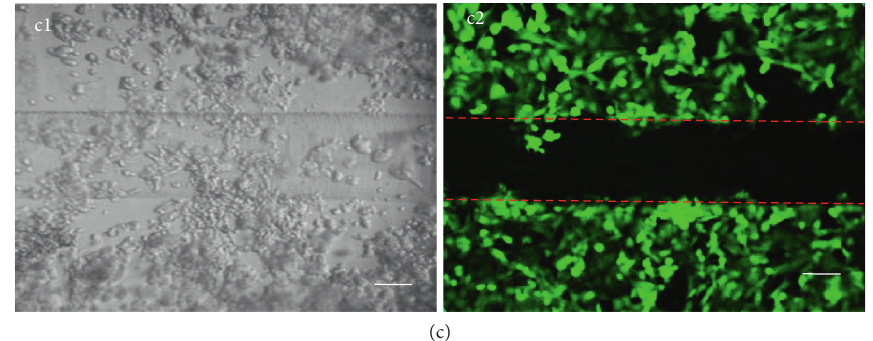
Figure 5: (a) Cells encapsulated within monolithic slab gels are considered as the control group. (b) Cells are encapsulated within the microfluidic network. (c) Cells encapsulated within the microfluidic network are cultured for 2 days. The cell morphology within the gel is shown by the microscopy (a1, b1, and c1). The live/dead staining of cells within the gel is shown by the laser confocal microscopy. Bar: 200 μ